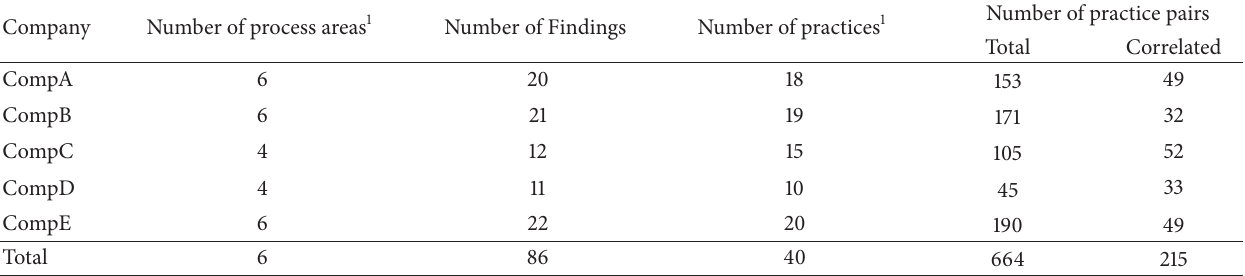
Table 3: Summary on collected